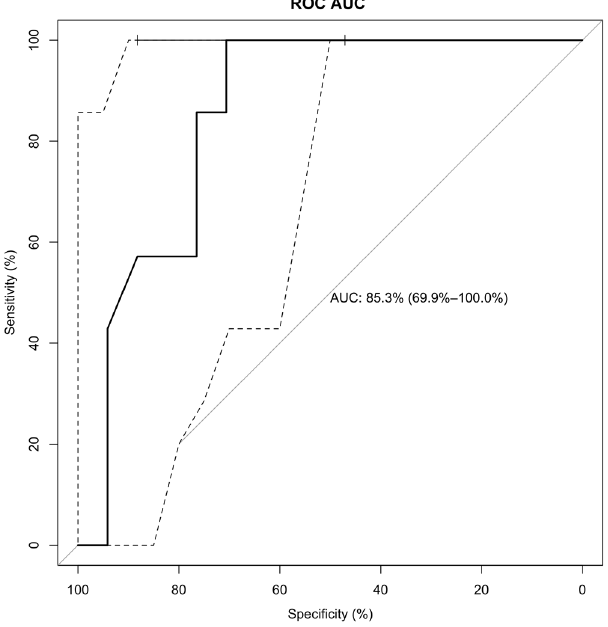
Fig. 4 Feasibility of point-of-care assessment. Logistic regression analysis including the non-invasive transdermal optical data and measured troponin- I values yield a sensitivity of 100% and speci fi city of 70.59%. The receiver operating characteristic curve indicates an average AUC of 0.853 for a bootstrapped